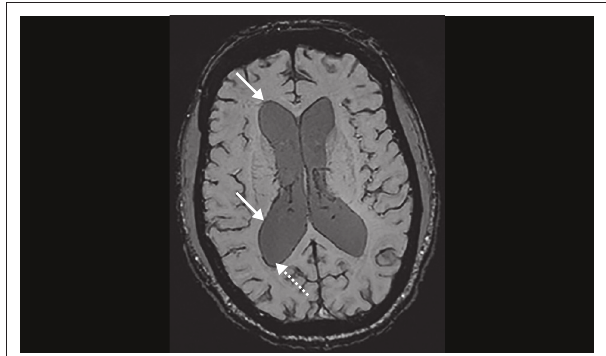
FIGURE 4: Susceptibility weighted imaging in a patient with a ruptured anterior communicating aneurysm. Haemosiderin staining the ependymal surface of the ventricles (white arrows), predominantly involving the dependent occipital horns (dashed white